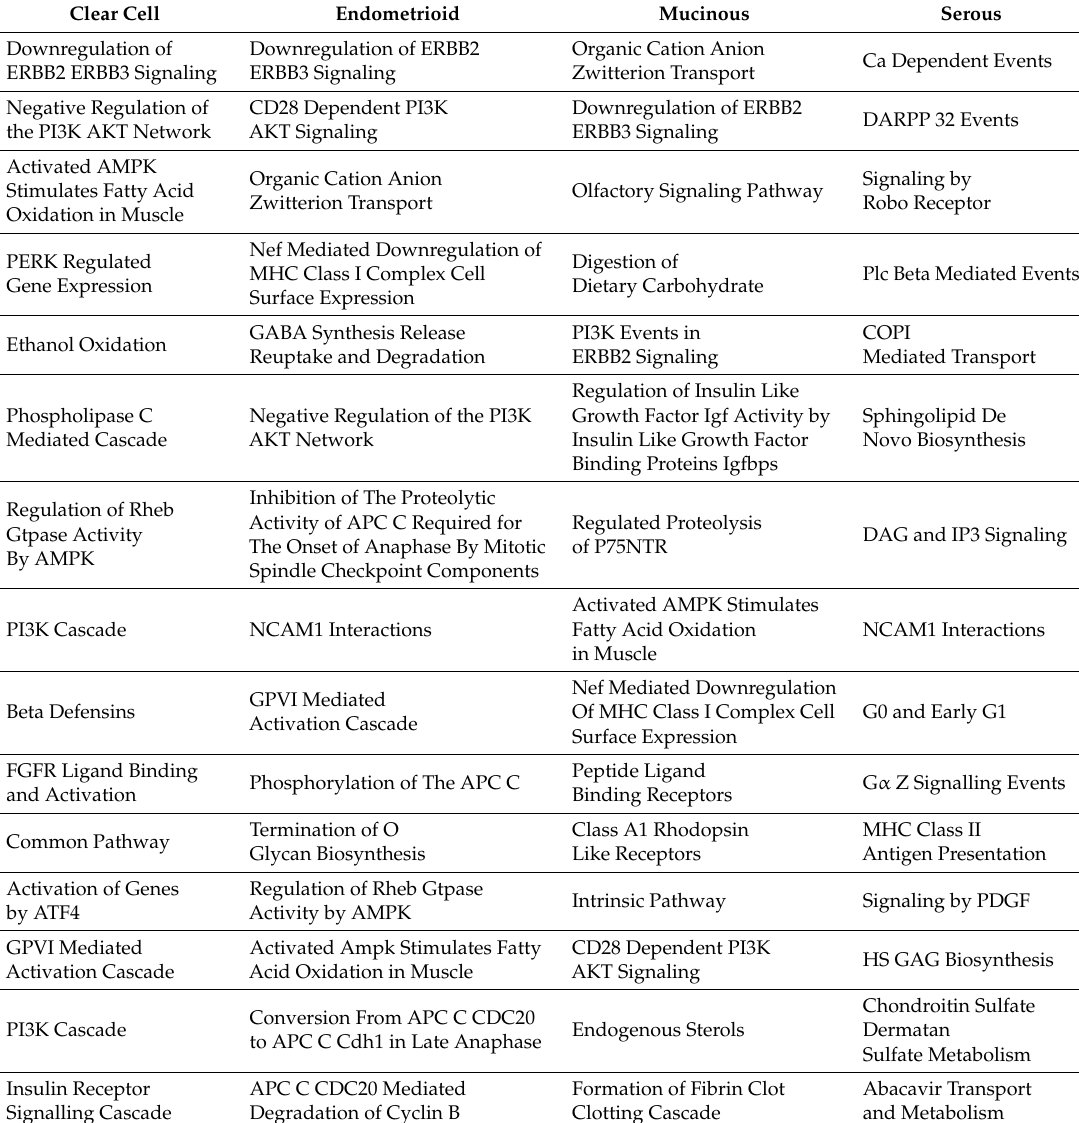
Table 4. The top 15 deregulated Reactome pathways ranked by the p values of each EOC subtype group. This table partially displayed the significantly deregulated Reactome pathways of each subtype. Only the top 15 deregulated Reactome pathway gene sets were